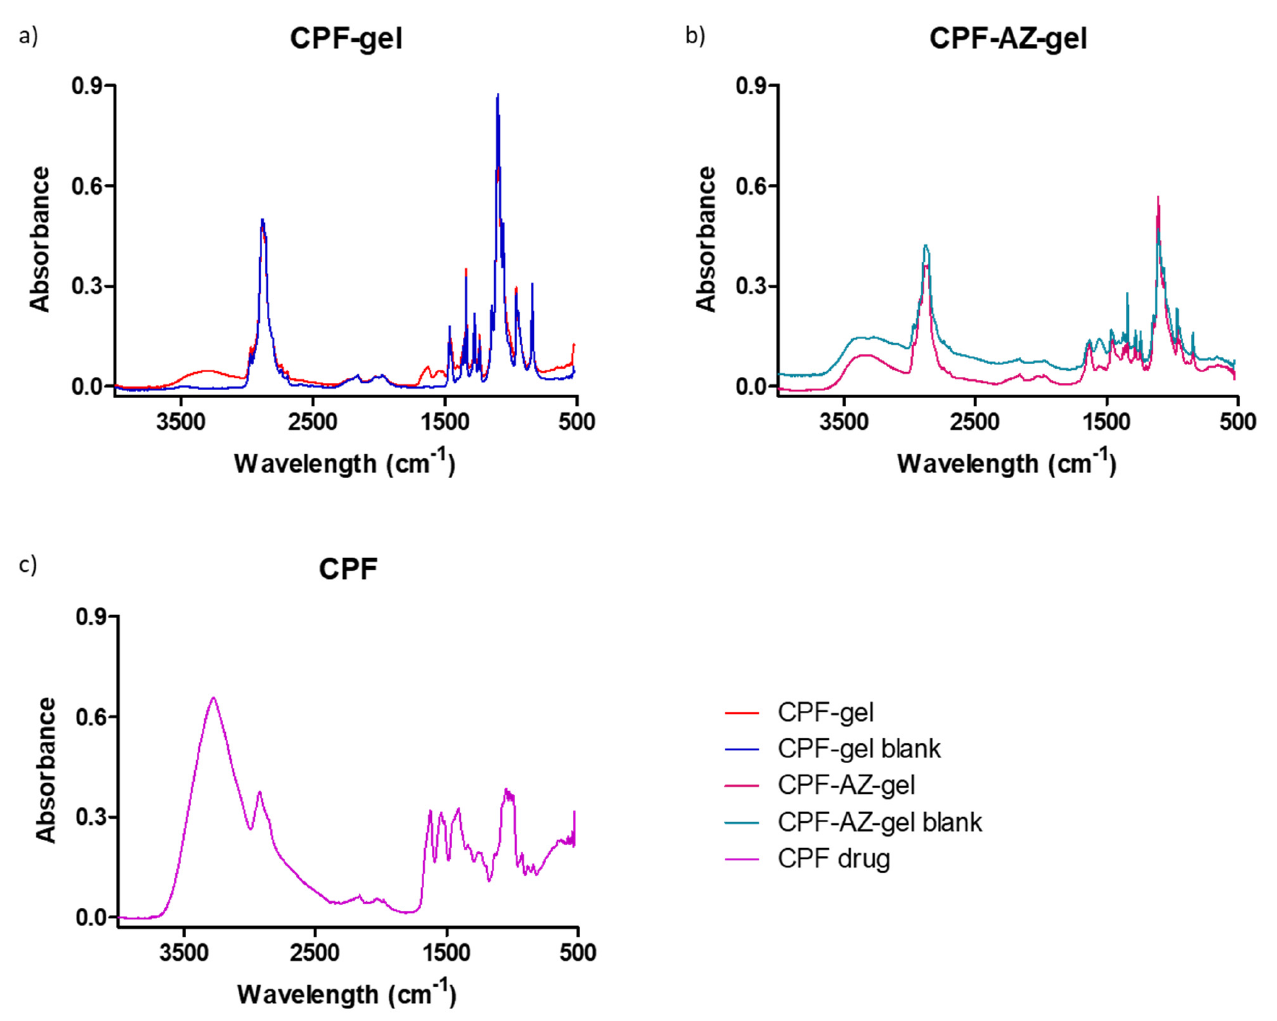
Figure 6. FTIR spectra for the gels: ( a ) CPF gel (red) and placebo (blue), ( b ) CPF-AZ-gel (pink) and placebo (cyan), and ( c ) caspofungin acetate salt Sun-Pharma (purple).